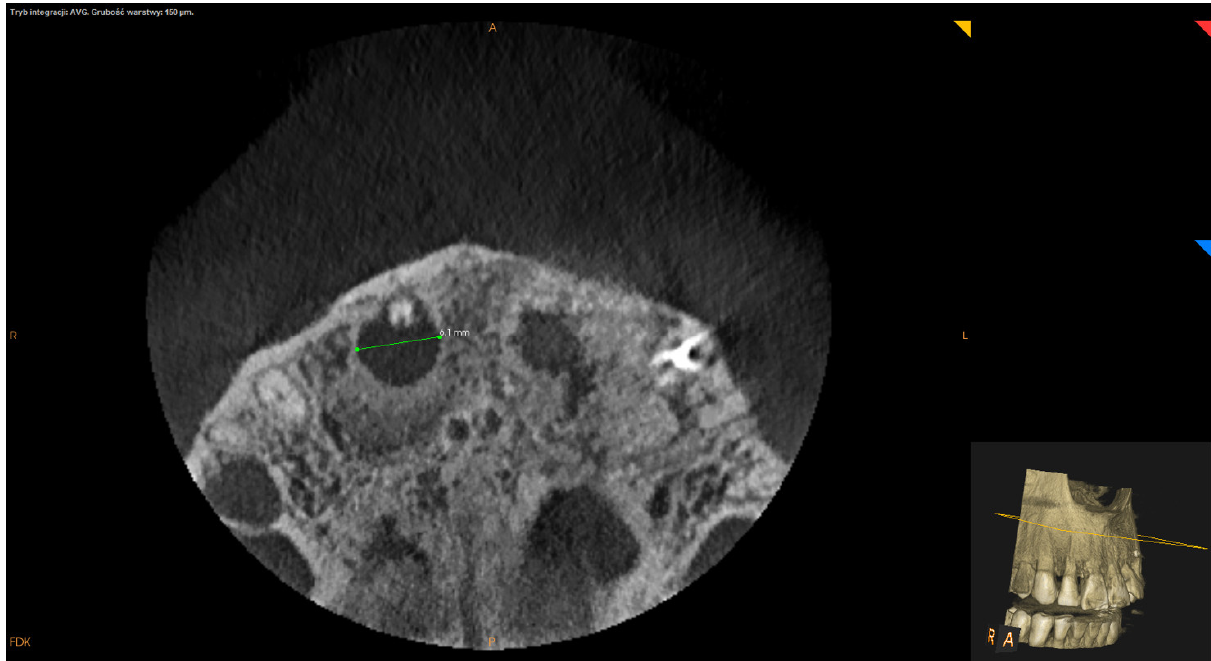
Figure 4. CBCT image (CS 8100 3D Carestream Dental ® ) measurement of mesiodistal maximum diameter in horizontal section. Non-English annotations present software technicalities (AVG integration mode and the layer thickness).